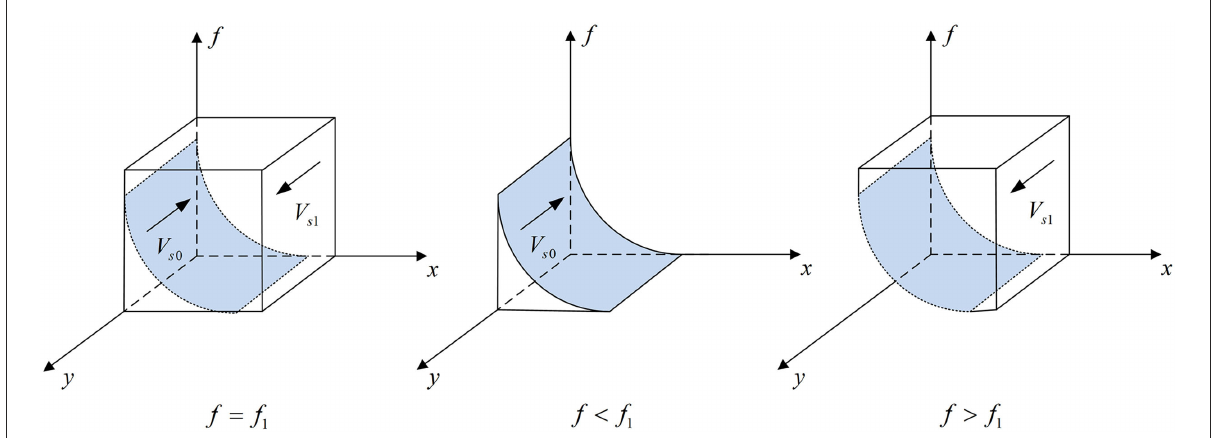
FIGURE3 Phase diagram of pharmaceutical enterprises’ strategic choice. Figure is the phase diagram that shows the evolutionary trend of pharmaceutical enterprises’ strategy obtained by calculating the response function of the probability of pharmaceutical enterprises choosing the “providing high-quality drugs”